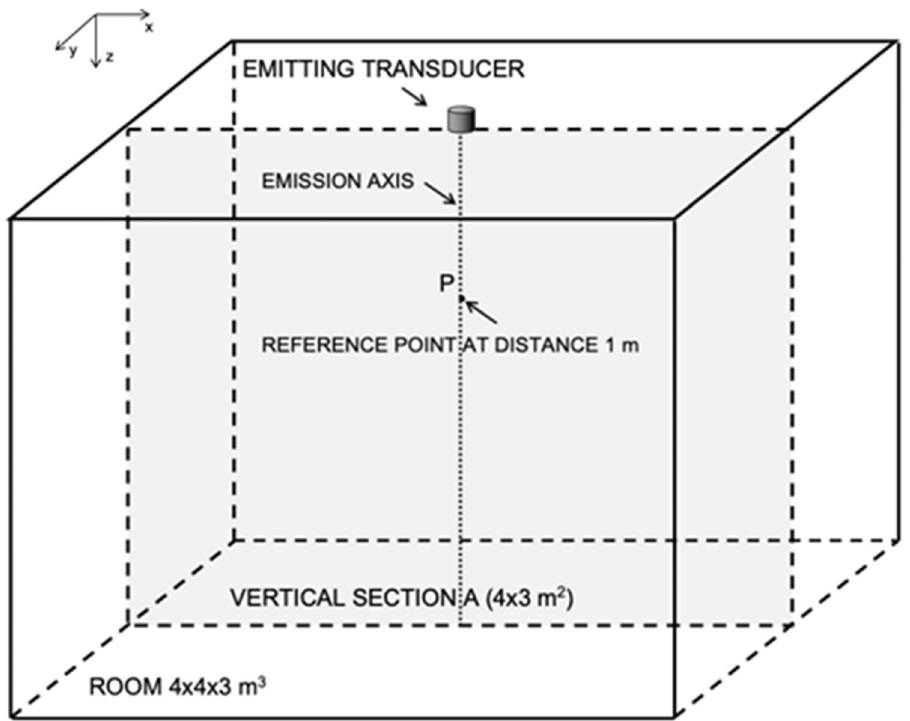
Figure 1. Simulation setup: the vertical section of the typical 4 × 4 × 3 m 3 room along which the ranging calculations using cross-correlation are computed. The SNR is considered at point P, namely at distance of 1 m from the emitter surface center and on its emission axis. Note that the simulation is carried out in a free space scenario with performances evaluated on the plane section A of 4 × 3 m 2 .